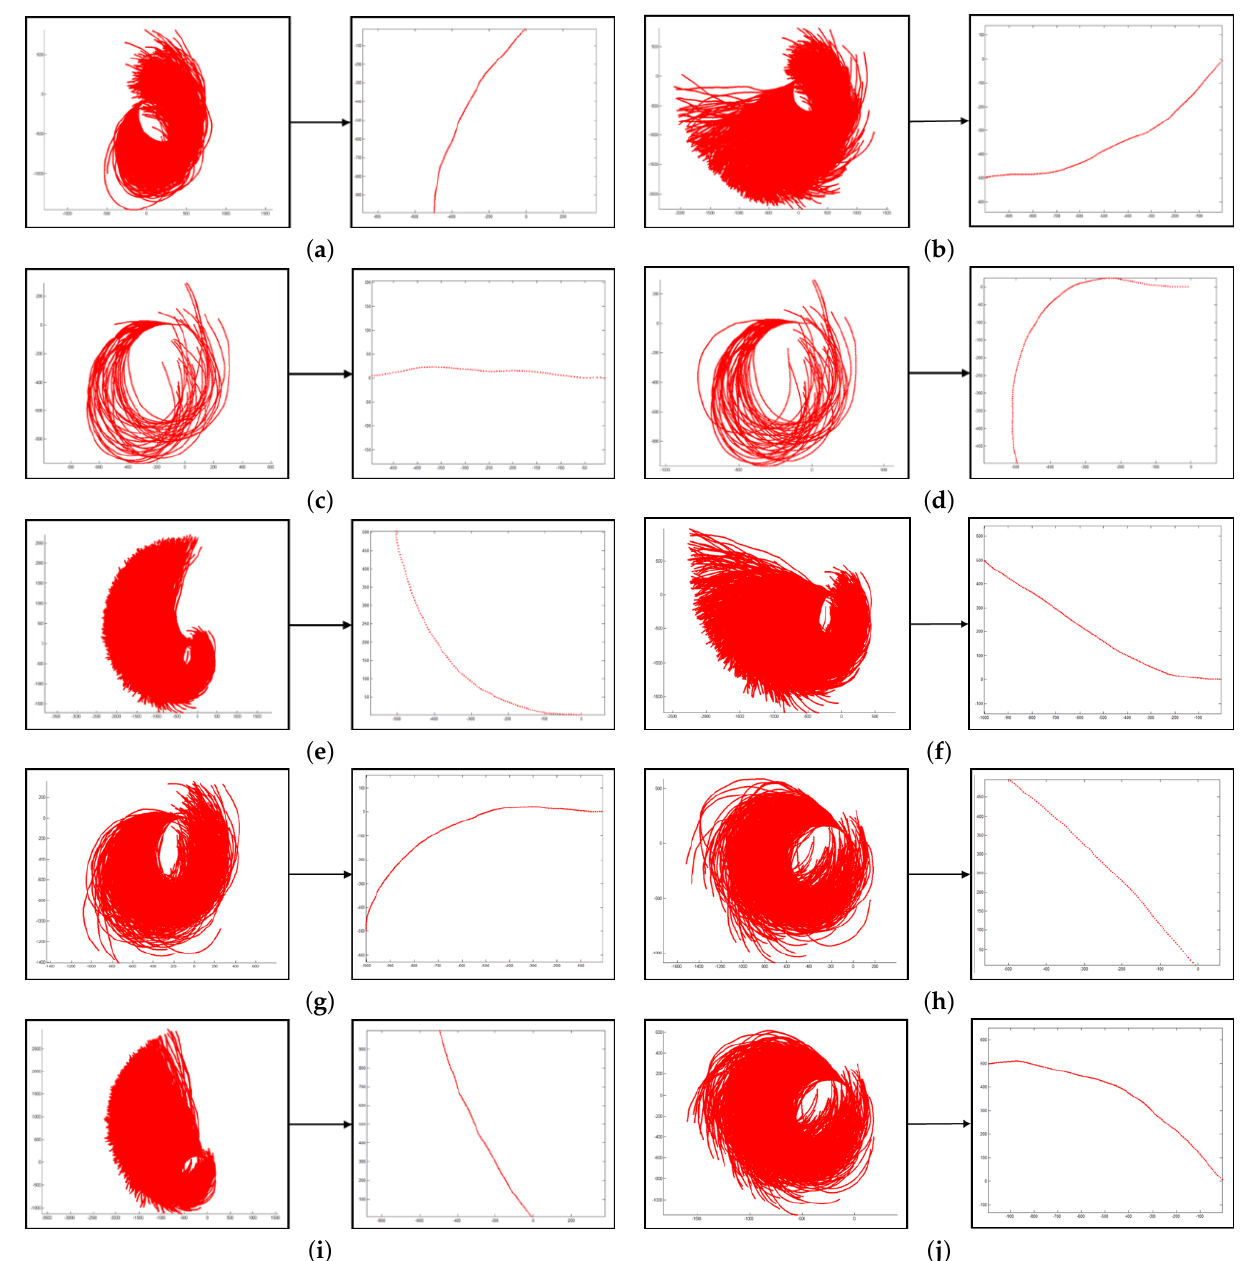
Figure A3. Regularization-trajectory cell library: the third section. ( a ) Time-varying trajectory cell from the initial 225 ◦ direction to 180 ◦ (rudder angle is − 25.79°). ( b ) Time-varying trajectory cell from the initial 225 ◦ direction to 270 ◦ (rudder angle is − 9.74°). ( c ) From the initial 270 ◦ direction to the 270 ◦ regularization-trajectory cell (rudder angle is − 34.68°). ( d ) Time-varying trajectory cell from the initial 270 ◦ direction to 180 ◦ (rudder angle is − 34.64°). ( e ) Time-varying trajectory cell from the initial 270 ◦ direction to 0 ◦ (rudder angle is 0.84°). ( f ) Time-varying trajectory cell from the initial 270 ◦ direction to 315 ◦ (rudder angle is − 13.68°). ( g ) From the initial 270 ◦ direction to the 225 ◦ regularization-trajectory cell (rudder angle is − 29.17°). ( h ) From the initial 315 ◦ direction to the 315 ◦ regularization-trajectory cell (rudder angle is − 29.96°). ( i ) Time-varying trajectory cell from the initial 315 ◦ direction to 0 ◦ (rudder angle is − 8.25°). ( j ) Time-varying trajectory cell from the initial 315 ◦ direction to 270 ◦ (rudder angle is −